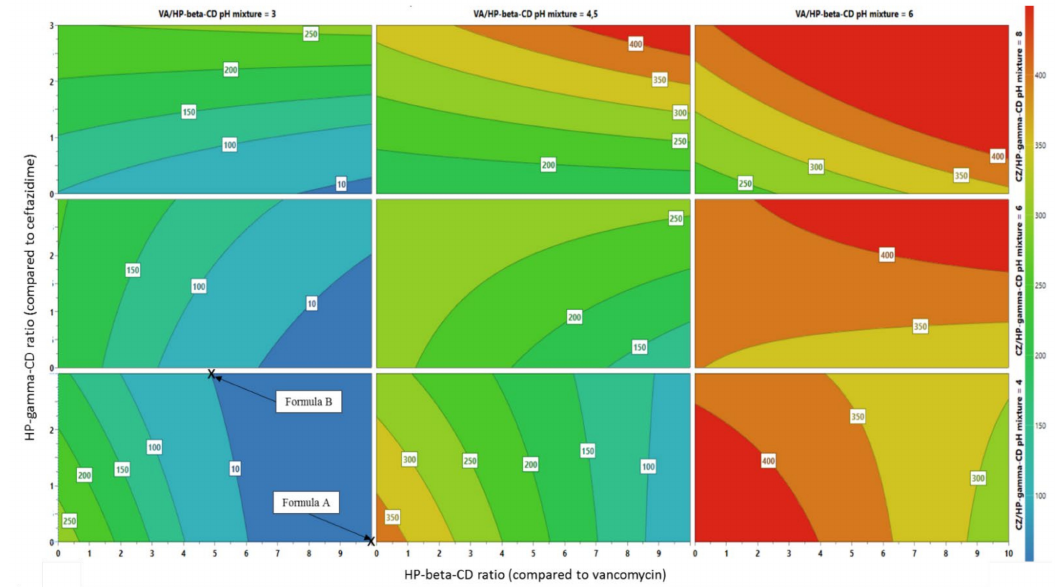
Figure 5. Variation of turbidity as function of simultaneous variation of parameters when stirring time of hydroxypropyl- β -cyclodextrins (HP β CD)—vancomycin (VA) fixed at 2 h, stirring time of Hydroxypropyl- γ -cyclodextrins (HP γ CD– ceftazidime (CZ) fixed at 0.5 h and final pH of the solution is at